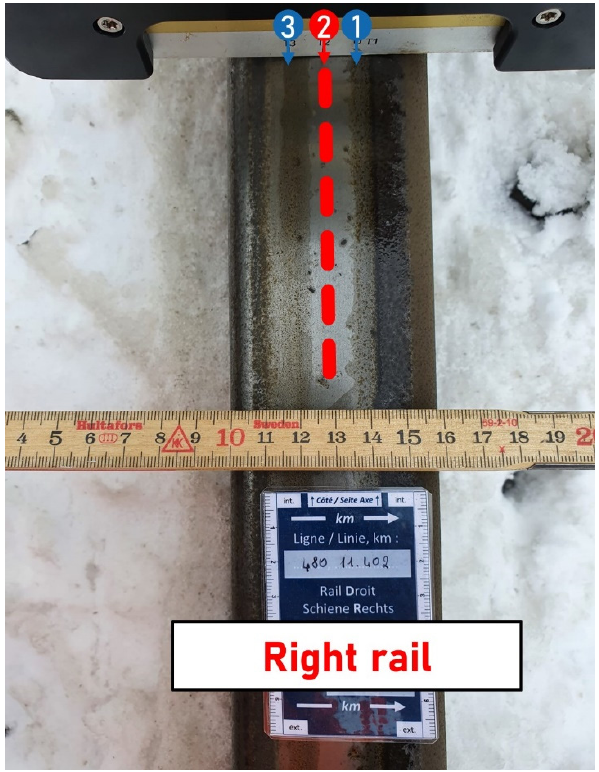
Figure 3. Tactile reference measurement on the right rail with the labelled positions of stylus 1, 2 and 3; image provided by SBB.